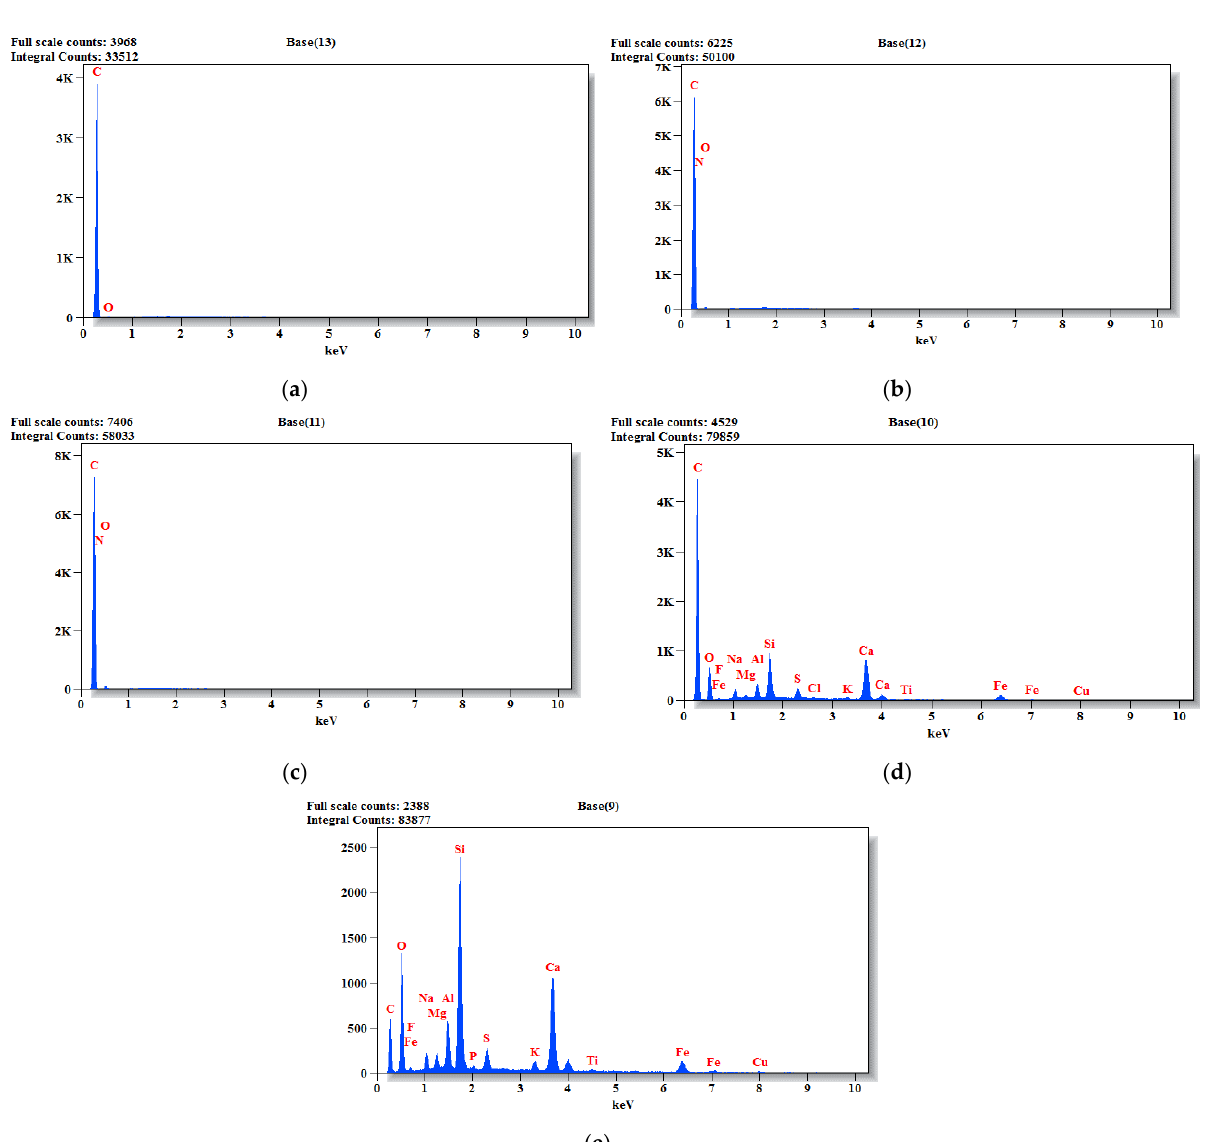
Figure 22. EDS results of carbon fibres subjected to elevated temperatures. ( a ) Room temper- ature; ( b ) 200 °C; ( c ) 400 °C; ( d ) 600 °C; ( e ) 800 °C.